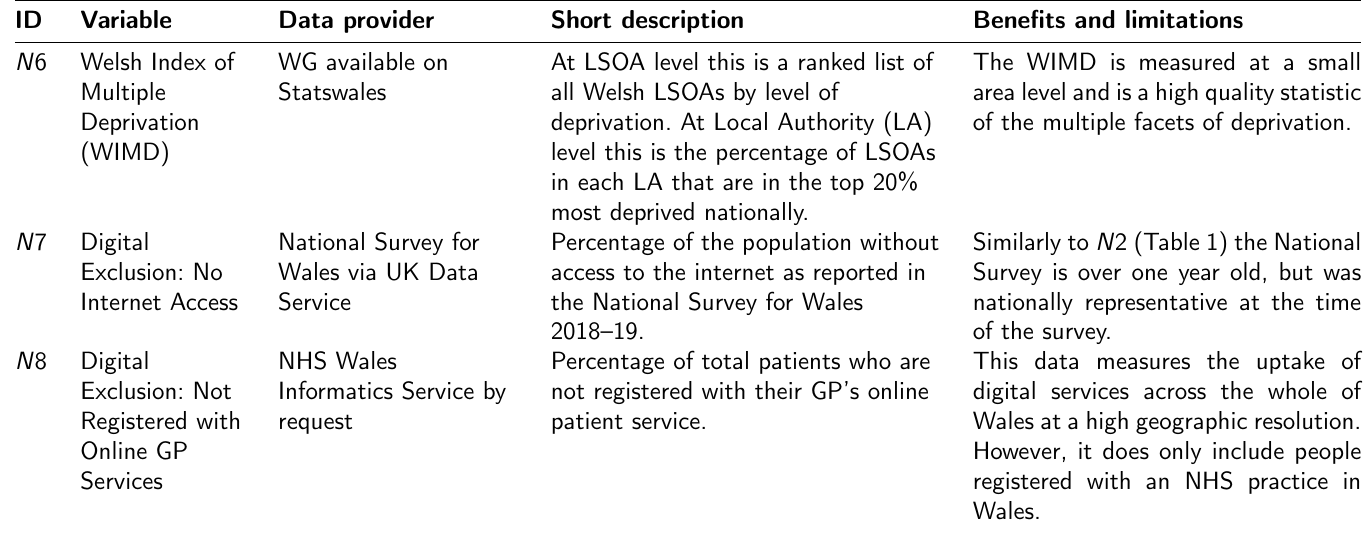
Table 3: Summary description of variables included in the deprivation and exclusion dataset